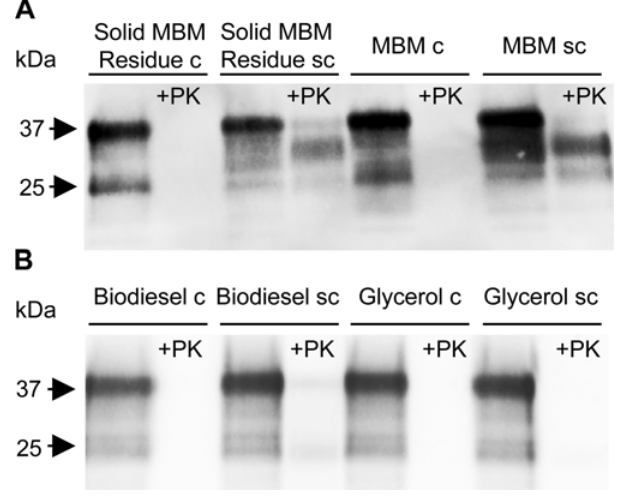
Figure 4. Western Blot analysis of hamster brains after termination of the infectivity bioassay. After the animal bioassay was terminated we evaluated brains from the different treatment groups for presence of PrP sc . We could detect PrP sc in brains from animals treated with infected solid MBM residue (4A, Solid Residue sc, + PK) as well as animals that received MBM spiked with infected brain (4A, MBM sc, + PK). Samples were digested with proteinase K to verify presence of PrP sc and detected with monoclonal (mAb) IPC1. Brain homogenates from inoculated biodiesel and glycerol fractions con- tained no PK resistant material whether derived from infected or uninfected MBM (4B). This suggests that death of animals inoculated with the solid MBM residue was definitely due to infection with scrapie whereas the biodiesel and glycerol phase of the reaction can be considered as decontaminated due to lack of any detectable protease resistant material in brains from animals injected with the respective